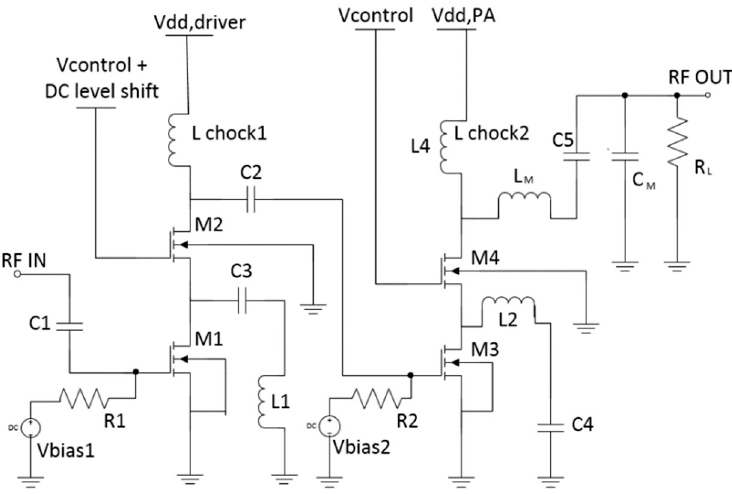
Figure 6. Linear power control cascode PA circuit [16].